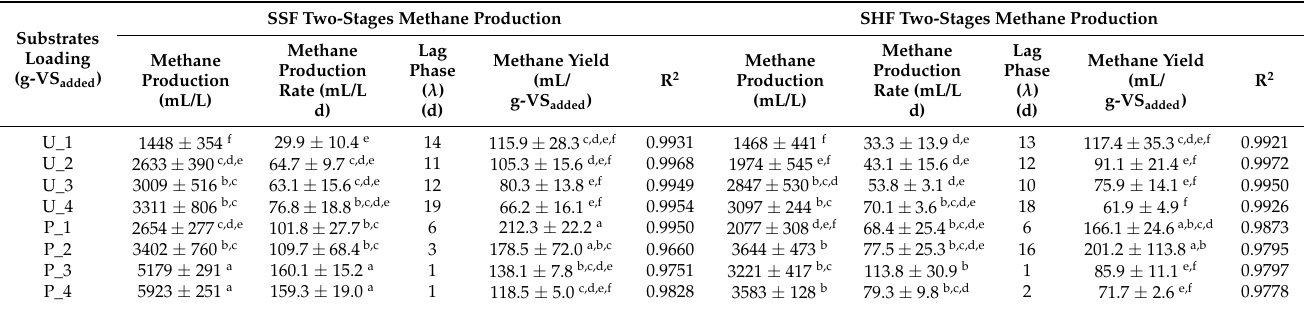
Table 6. Comparison of methane production by SSF and SHF of the two-stage methane production process.